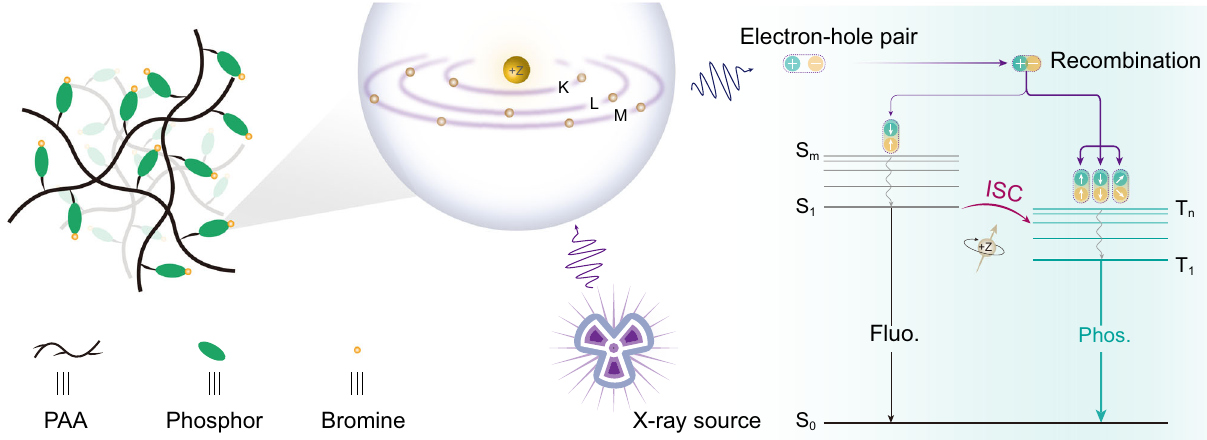
Fig. 1 Rational design of amorphous copolymers for organic phosphorescent scintillation and the related emissive processes under X-ray irradiation. After X-ray irradiates the polymers and ejects the inner electrons of the halogen atoms, plenty of electrons and holes are produced. Then the recombination of holes and electrons produces singlet and triplet excitons. Among them, radiative transitions of the excitons generate radioluminescence under ambient conditions. Fluo. and Phos. refer to fl uorescence and phosphorescence, respectively.